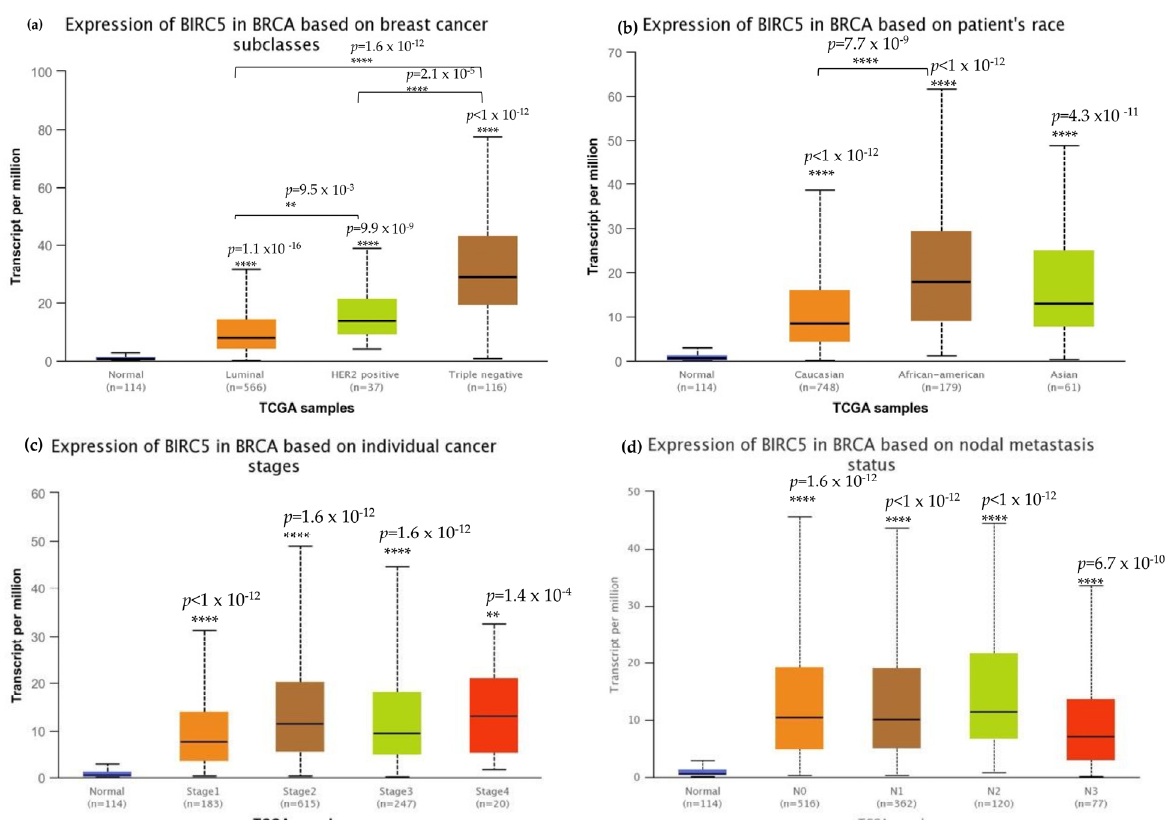
Figure 3. Breast cell carcinoma transcript expressions across cancer stages. ( a ) Expression of BIRC5 transcripts in different breast carcinoma histological grades. All BC subtypes of BIRC5 transcripts increased, with TNBC showing the highest expression. ( b ) BIRC5 expression among different patients’ races, in which AA show high expression. ( c ) In comparison to normal tissues, BIRC5 transcripts were markedly upregulated at all tumor stages. ( d ) Metastatic tissues express BIRC5 transcripts. Greater nodal involvement was associated with higher BIRC5 transcript levels ( p < 0.01). ( d ) RNAseq data from TCGA datasets were analyzed using UALCAN to produce all graphs. ** p < 0.01, and **** p < 0.0001.